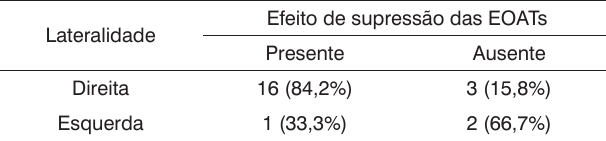
Tabela 2. Lateralidade e ocorrência do efeito de supressão das EOATs na orelha direita.